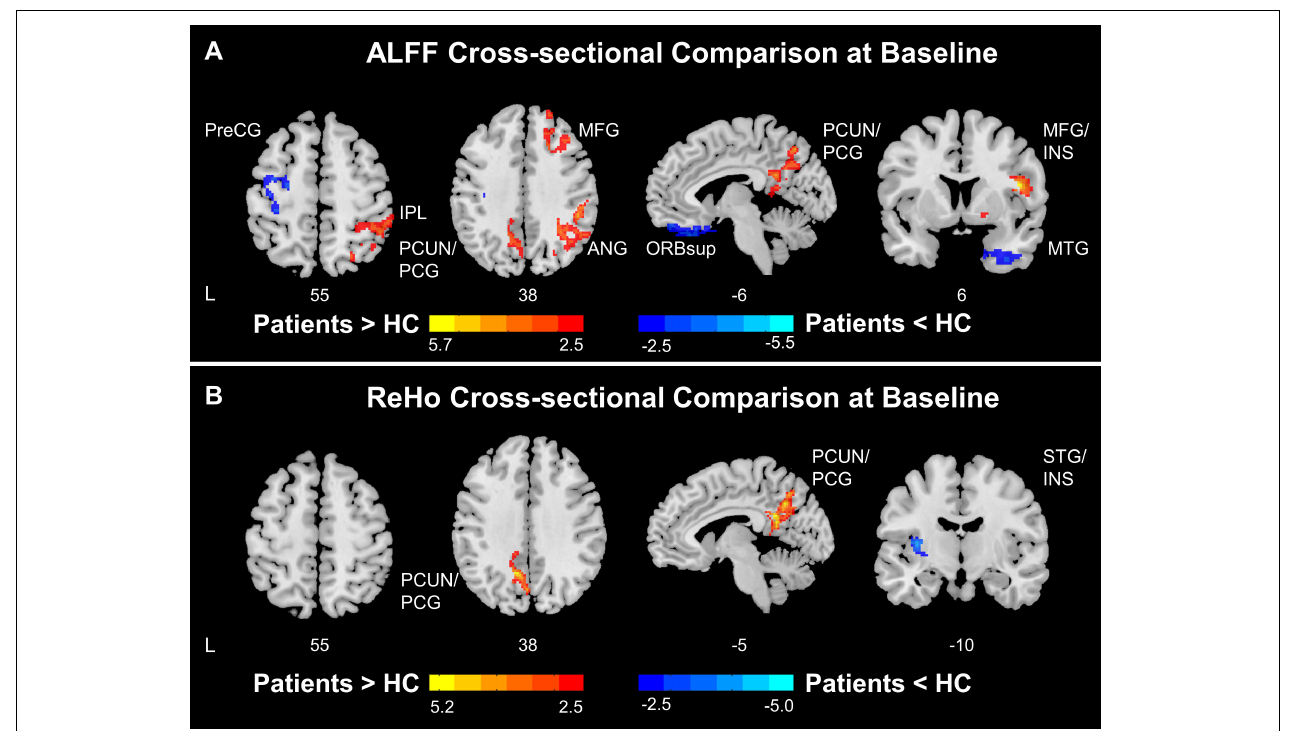
FIGURE 2 | Functional disruptions in stroke patients. (A) ALFF comparison between HC and patients at baseline. At baseline, stroke patients showed reduced ALFF at ipsilesional SMN and increased ALFF at DMN and salience network comparing to healthy controls. (B) ReHo comparison between HC and patients at baseline. At baseline, stroke patients showed increased ReHo at DMN and decreased ReHo at insula comparing to healthy controls. Color bars indicate t-scores. L, Ipsilesional Hemisphere; DMN, Default Mode Network; SMN, Somatomotor Network; HC, Healthy Control; Precg, Precentral Gyrus; SMA, Supplementary Motor Area; IPL, Inferior Parietal; PCUN, Precuneus; PCG, Posterior Cingulate Gyrus; MFG, Middle Frontal Gyrus; ANG, Angular Gyrus; ORBsup, Superior Frontal Gyrus, Orbital Part; INS, Insula; MTG, Middle Temporal Gyrus.